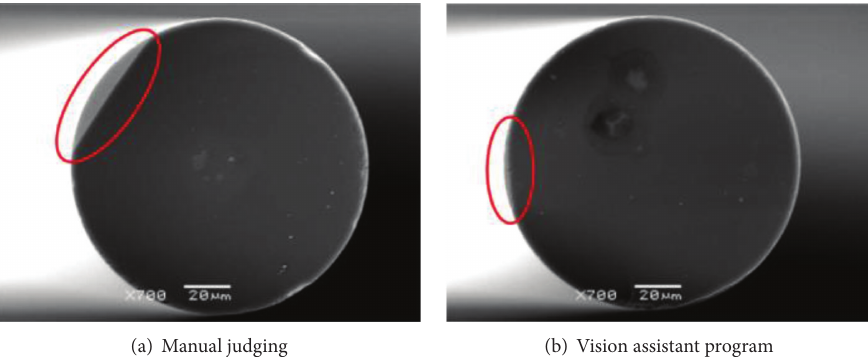
Figure 8: SEM photos of the end-face of the optical fiber.